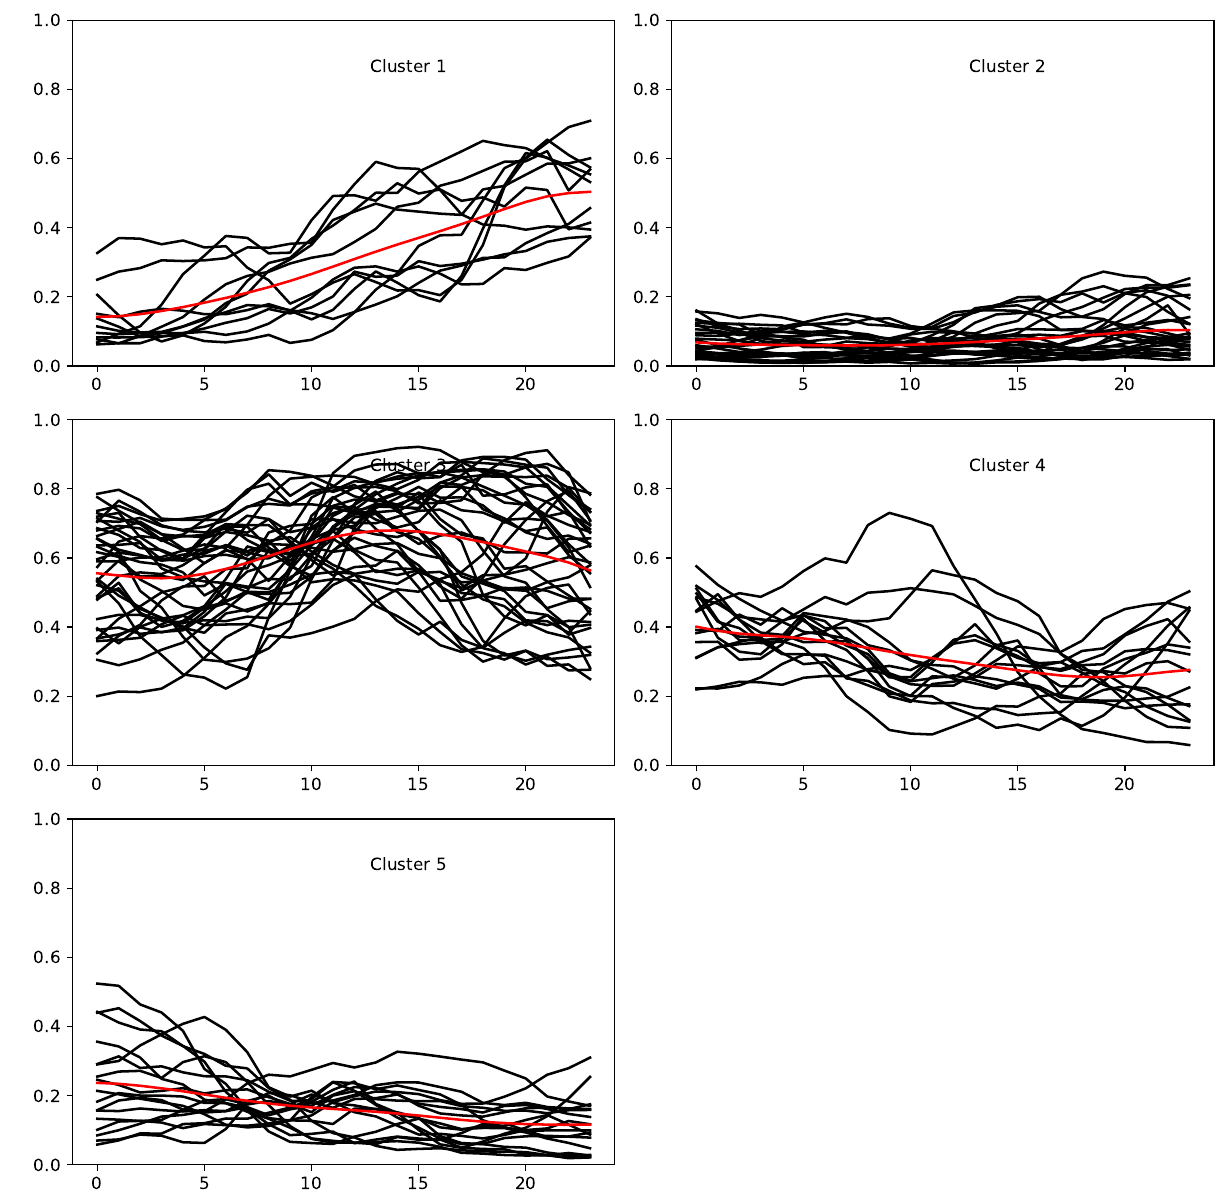
Figure A6. Season 3 wind generation data